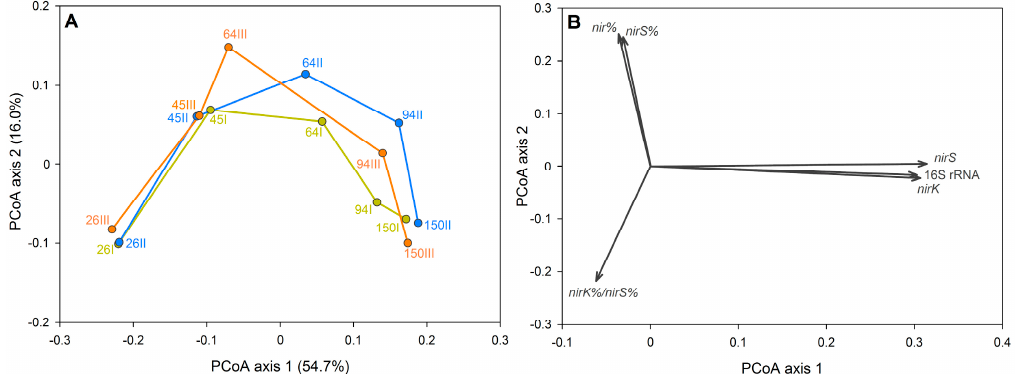
Figure 2. Principal coordinate analysis ( A ) based on Bray-Curtis distance matrix of 15 WMB samples, where lines connect samples from the same mesocosms, Arabic numerals in symbols indicate days of system operation and Roman numerals indicate parallel mesocosms; and ( B ) correlation of principal coordinates axes with 16S rRNA, nirK and nirS gene abundance and proportion